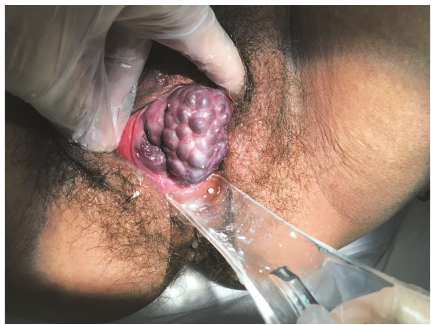
Figure 2: Vaginal Varicosities exposed during vaginal speculum